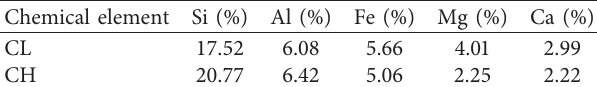
Table 5: Results of XRF